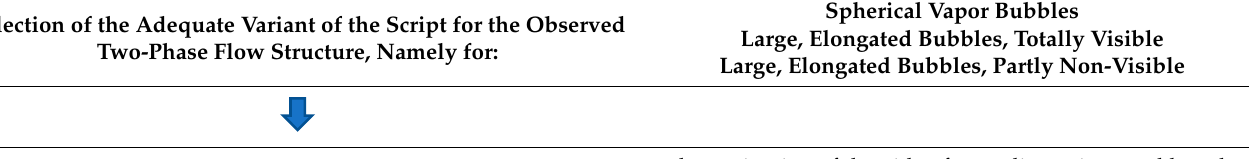
Table 1. Global scheme of the Matlab script functioning.